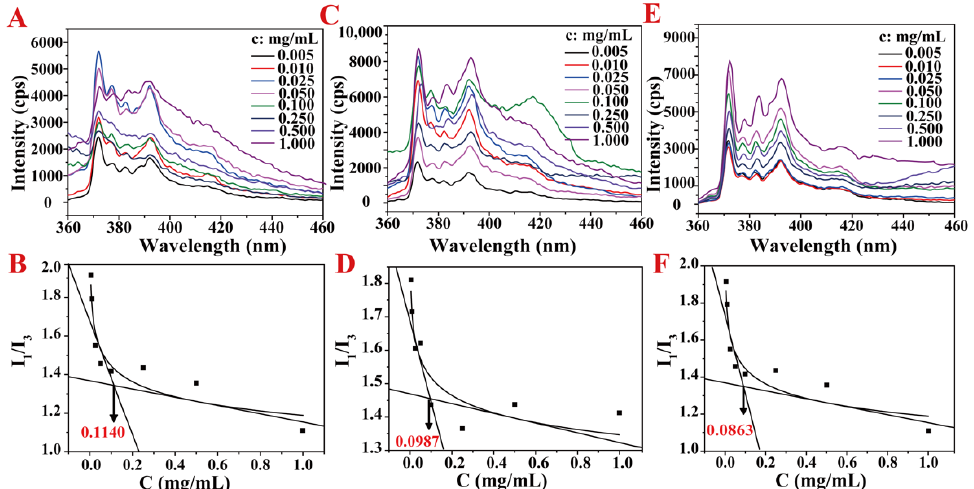
Figure 4. Fluorescence emission spectra ( A , C , E ) and the relative curve of I 1 /I 3 vs. concentration ( B , D , F ) of pyrene in PLENB solution. ( A , B ) PLENB1, ( C , D ) PLENB2, ( E , F ) PLENB3.